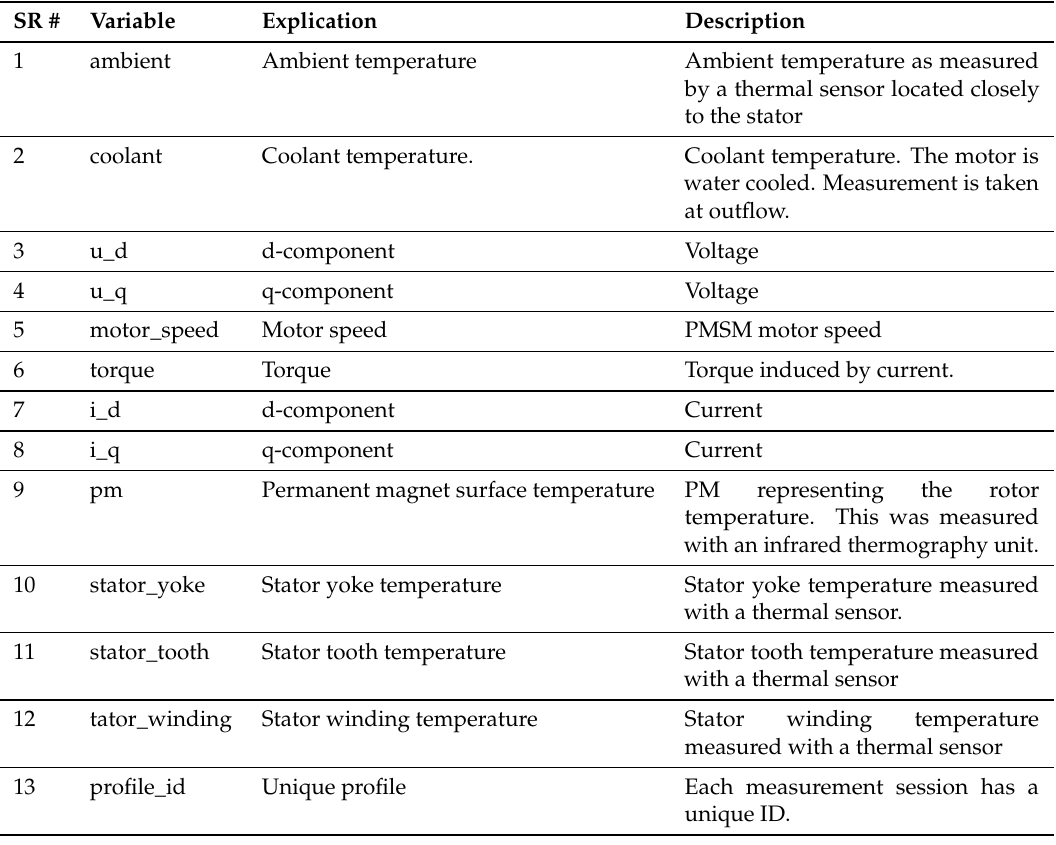
Figure 11. Process flow chart for prediction using machine learning. Table 2. Input variables along with